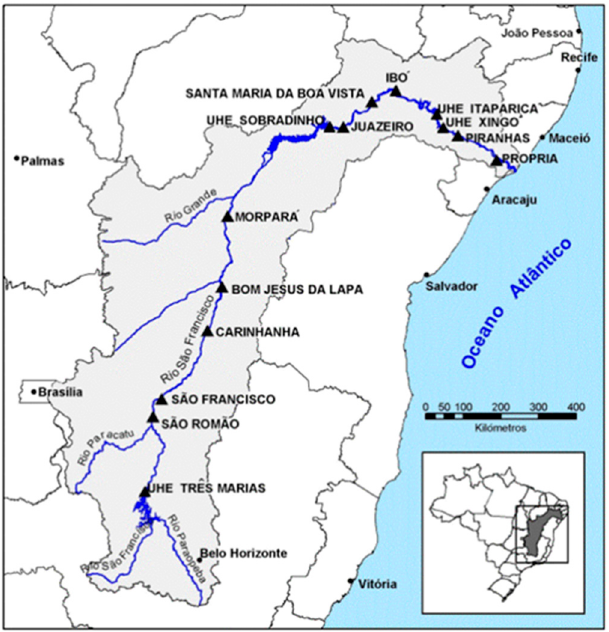
Figure 2. São Francisco River Basin (SFRB) and its insertion in the national territory, with main Hydropower Plants (HPPs) and fluviometric stations [26].